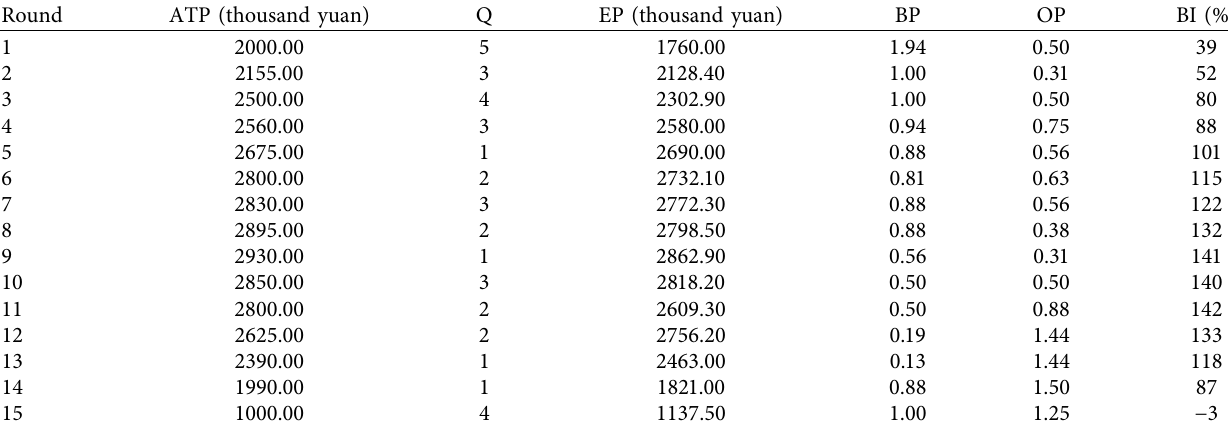
Table 3: Statistical indicators of low deposit interest rate group.